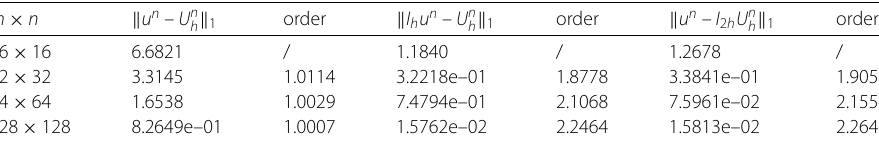
Table 7 Numerical results of u at t = 2 m × n